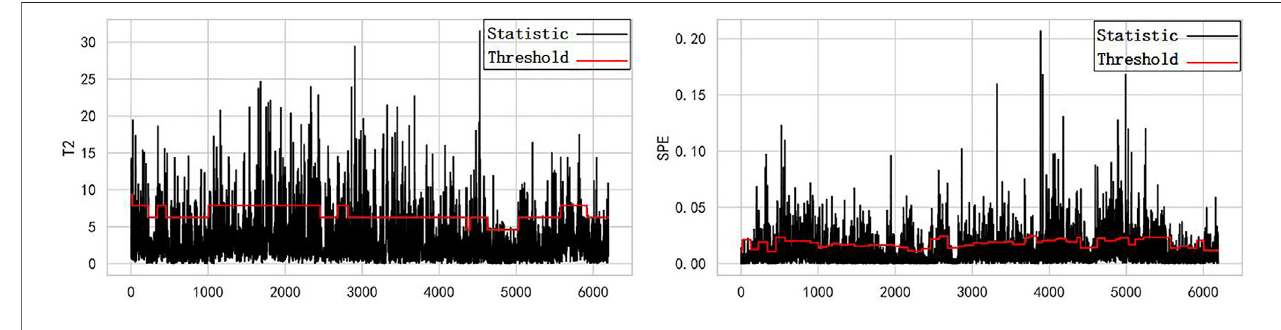
FIGURE 2 | Determination results based on MWKPCA.